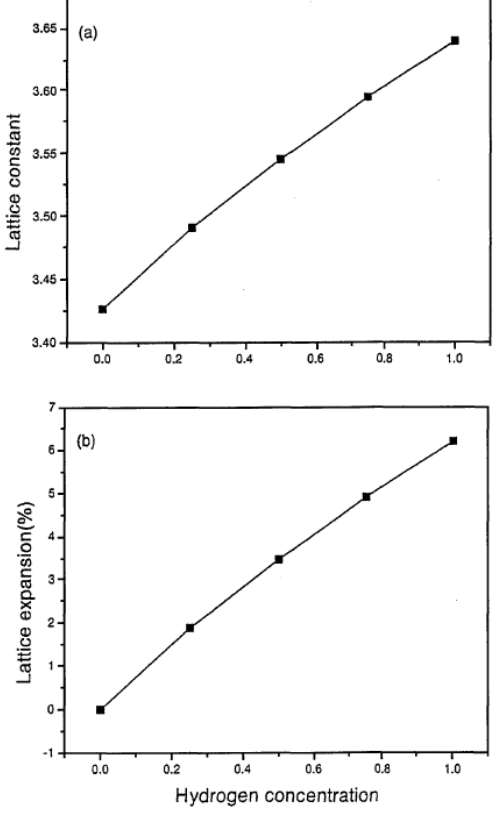
Figure 6. Lattice constant ( a ) lattice expansion ( b ) changes with concentration of Hydrogen [60].